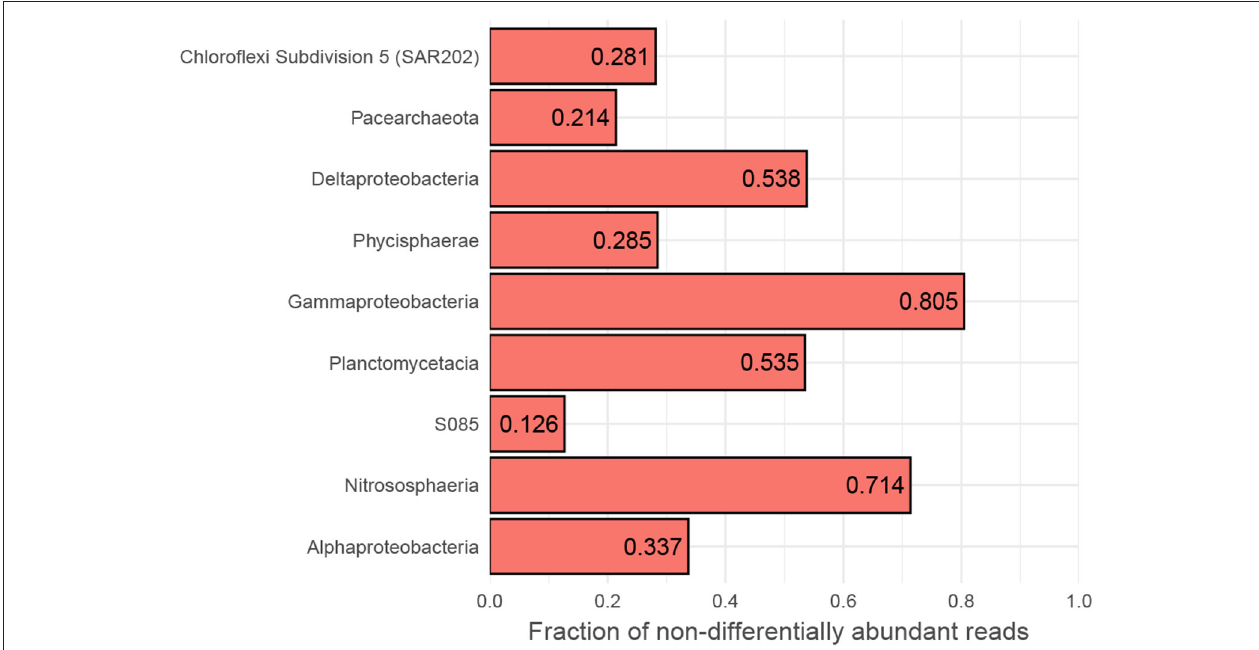
FIGURE 6 | Fraction of non-responsive OTUs. Binning to class level of OTUs belonging to the 10 most abundant classes that are not differentially abundant between high- and low-oxic/anoxic (cat. 1 vs. 6 and 7) conditions in AMOR sediments. MD2896-B214 has no non-differentially abundant OTUs and is, therefore, not shown. A broad column suggests that OTUs accounting for most of the class’s reads are too variable within oxygen categories compared to between to be labelled as differentially abundant.